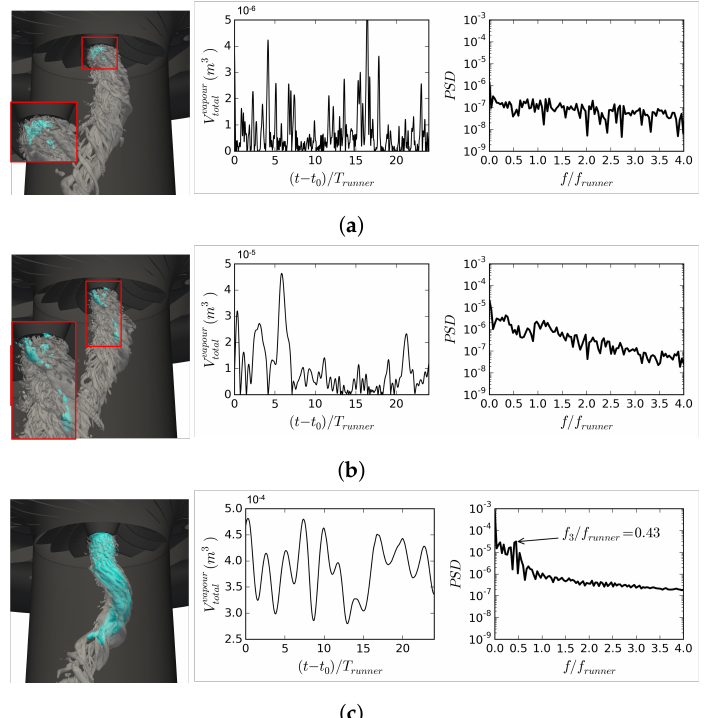
Figure 12. Cavitating regions in the RVR, shown by the blue iso-surface of α v = 0.99, for different cavitation numbers, ( a ) σ = 0.07, ( b ) σ = 0.06 , ( c ) σ = 0.05, The RVR is shown by a transparent gray iso-surface of Q = 5000 s − 2 . Plots show variation of total volume of vapor (with different scales on y-axis for different cavitation numbers) in the RVR as well as spectral analysis of this variation.